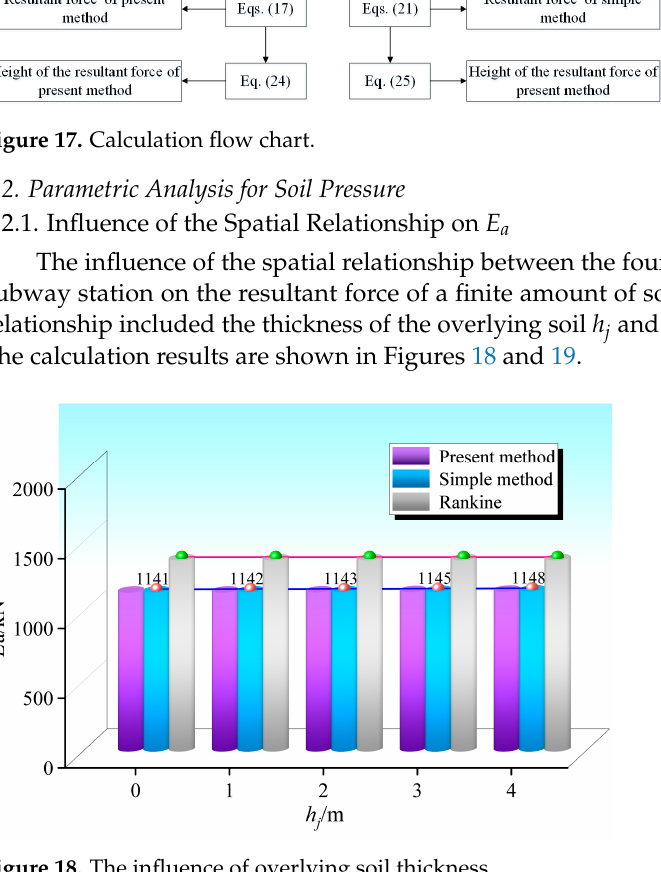
Figure 19. The influence of finite soil width. Figures 18 and 19 show the influence of overlying soil thickness and the finite soil width on E a , indicating that the resultant force of a finite amount of soil is quite different from the Rankine soil pressure. This force increases with increasing h j and b . However, the influence is very small because the changes in h j and b cause no change in the slip surface inclination angle and only a small change in the soil slip area. 6.2.2. Influence of Friction Angles on E a The influences of the friction angles on the resultant force of a finite amount of soil were studied. The friction angles include the internal friction angle φ , the friction angle between the enclosure structure and soil δ 1 , and the friction angle between the existing subway structure and soil δ 2 . For the friction angle between the structure and soil, δ , δ 1 = δ 2 = δ is assumed to simplify the parameters [1]. The calculation results are shown in Fig- ures 20 and 21.